Question: What does this figure show? Answer in one sentence.
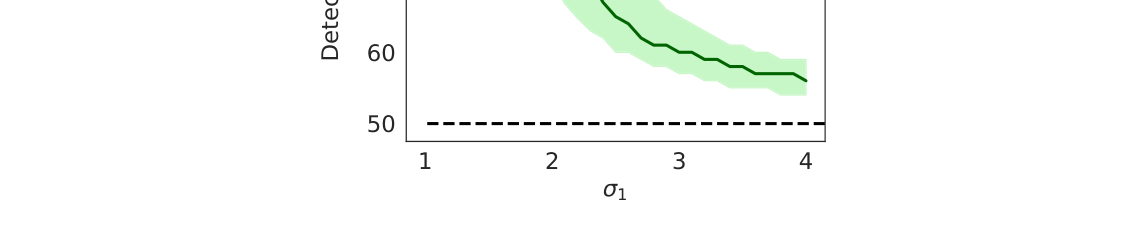
Answer: 2 – Comparison of median confidence envelopes around the mean for N(0, 1), E(1), B(0.8) and χ2(5), as a function of the sample size t, over 1000 independent replicates. Grey lines are trajectories of empirical means bµt.